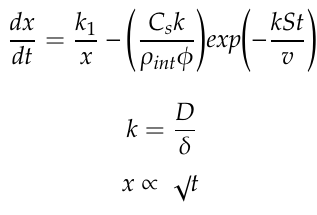
Figure 4. SEM-EDS analysis of Fe-containing phases formed a little away from the cast iron/liquid aluminum interface isothermally heated at 720 °C for different times: ( a ) 1 min and ( b ) 5 min.